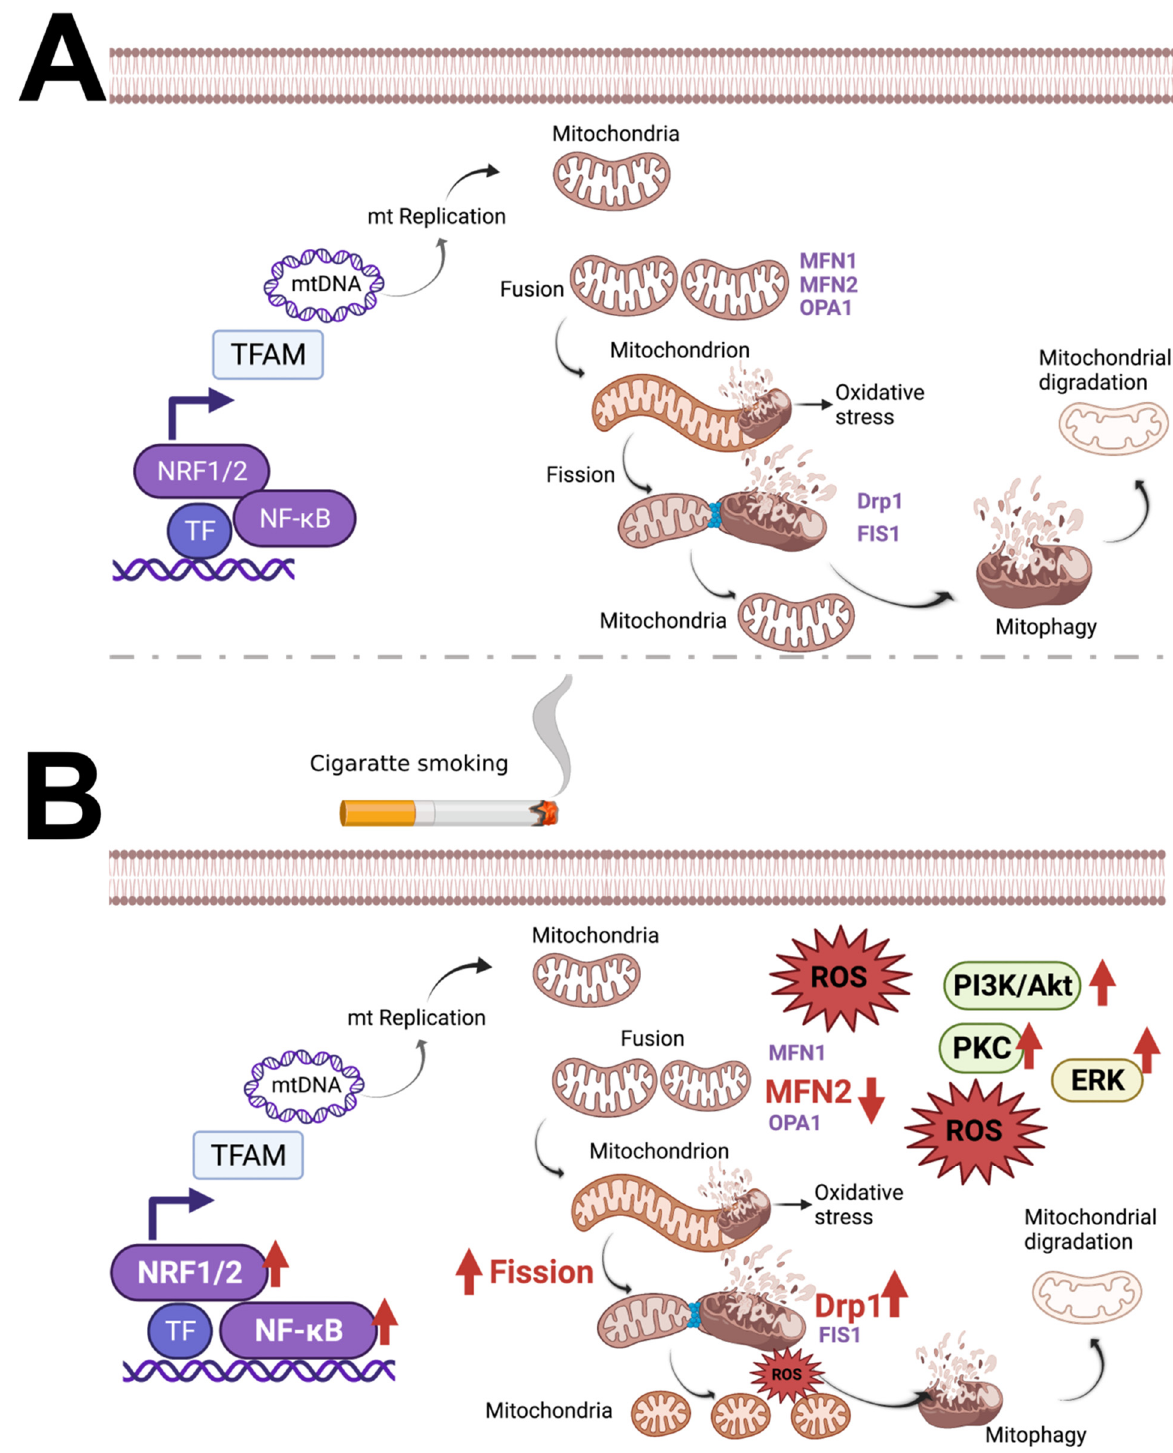
Figure 2. Mitochondrial quality control pathways in healthy cells and CSE treated cells. ( A ). Mitochondrial biogenesis and network regulation rely on key transcription factors and various proteins to maintain the processes needed for the organelle’s homeostasis. Mitochondrial transcription factor A (TFAM) acts on mtDNA after being imported into mitochondria and is an essential transcription factor needed to encode mitochondrial proteins. The first of these proteins transcribed include electron trans- port chain subunits to increase and maintain the appropriate number of mitochondria to sustain oxygen consumption and ATP synthesis. Secondly, fusion proteins (MFN, MFN2, and OPA1) mitochondrial